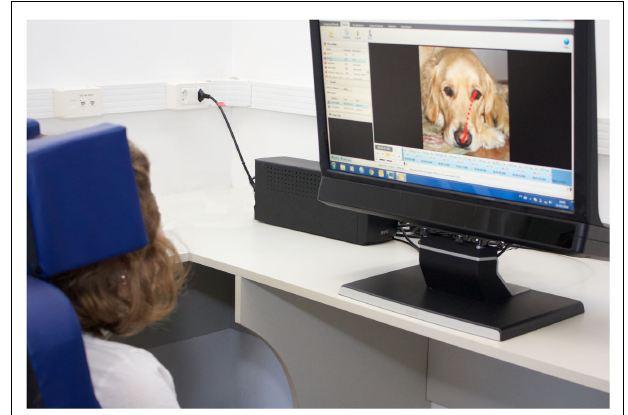
FIGURE 1 | Illustration of the experimental situation using a video-based eye-tracking system in our laboratory . Using an eye tracker, we can monitor where the child is looking (photograph of Sarah Kuwano Molinari Salotti).